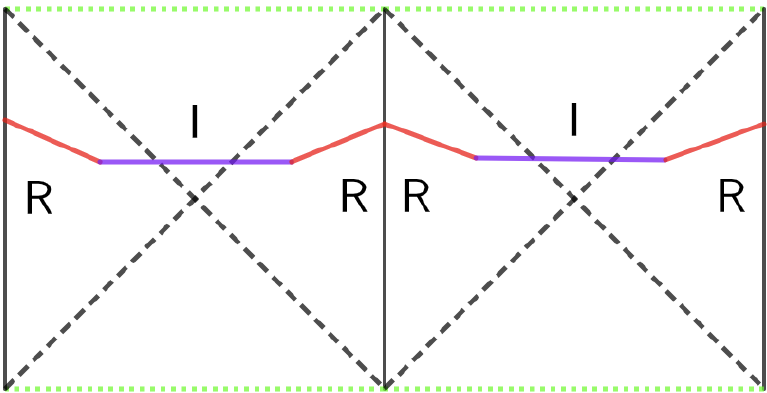
Figure 14 . Penrose diagram for case II: two two-side black holes. The left and right vertical lines are glued together. The black-dotted, green-dotted, red, and purple lines denote the horizon, singularity, radiation region, and island region,